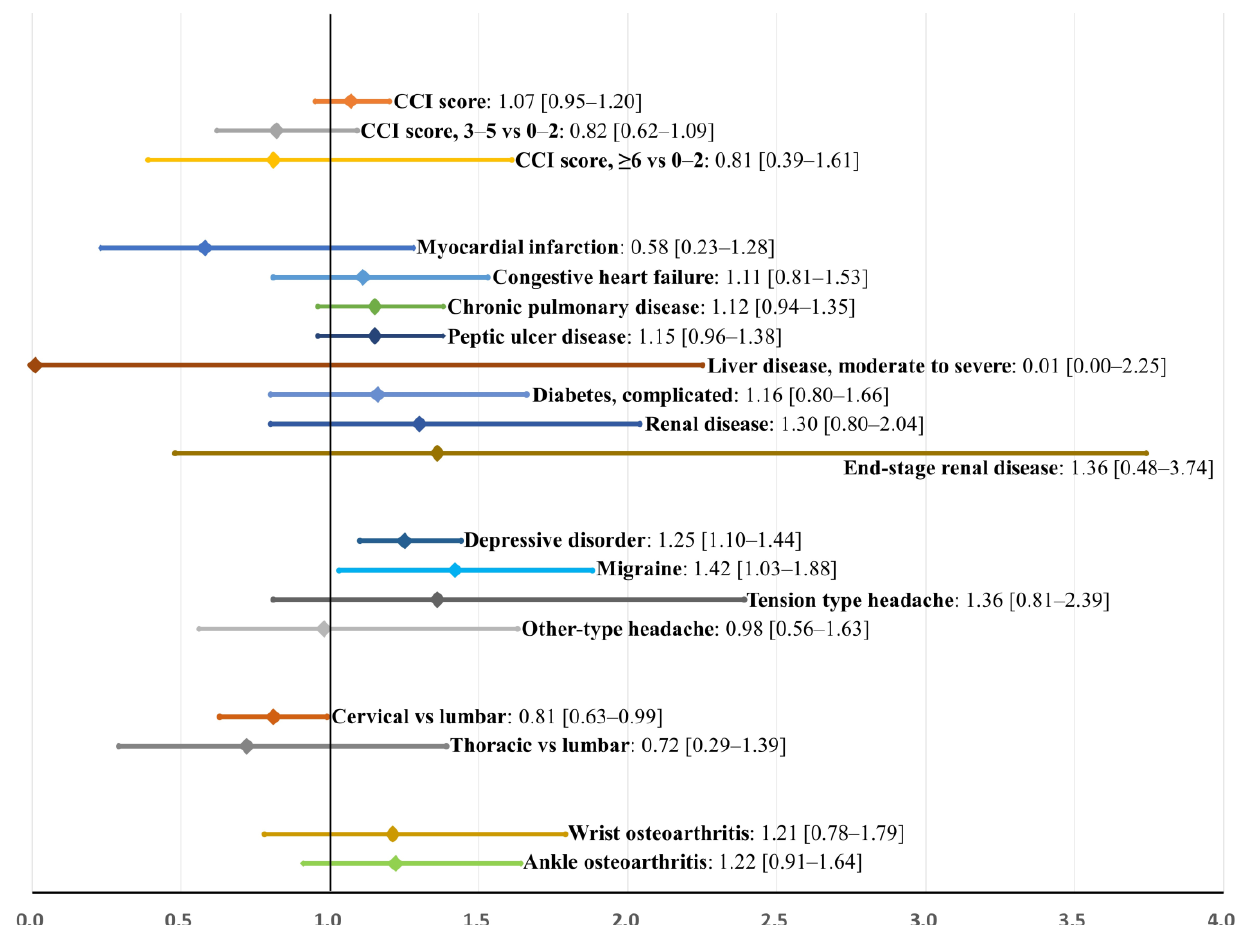
Figure 10. Factors associated with non-improvement in sleep medication after surgery: a multivar- iable analysis. Bootstrap-adjusted odds ratios and their 95% confidence intervals are presented.